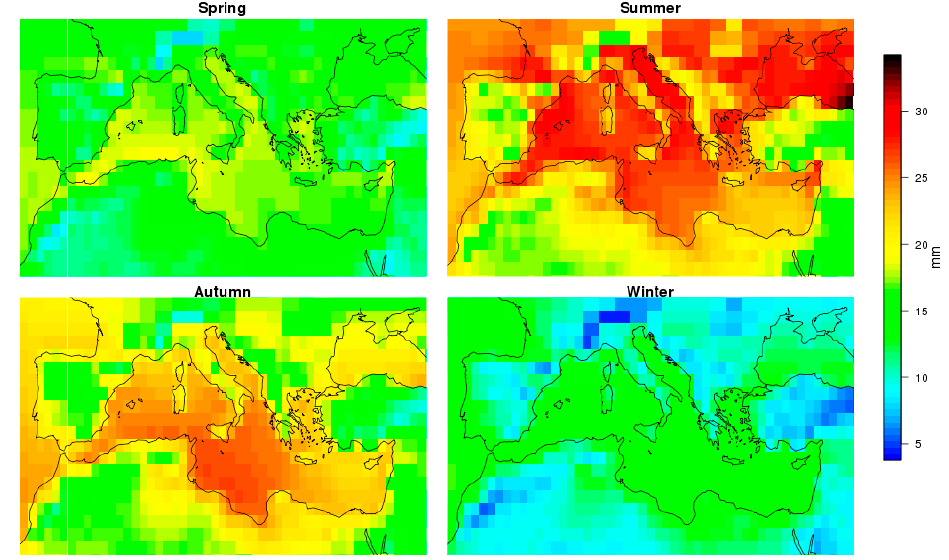
Figure 4. Distribution of seasonally averaged PWV in the Mediterranean basin during the period 2000–2018.